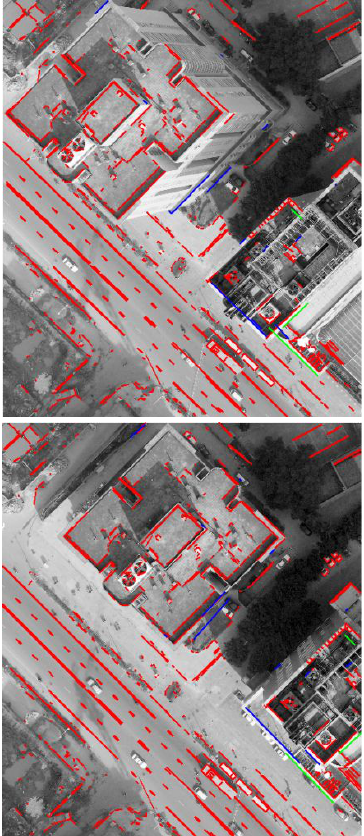
Fig. 12. Patch #2 - Red lines are correct matches, blue lines are wrong matches, and green lines are line endpoints are extended to occlusion areas in one of the image, but the result is correct.. Matches: 766(862/965) line sets. Incorrect: 14. Occlusion: